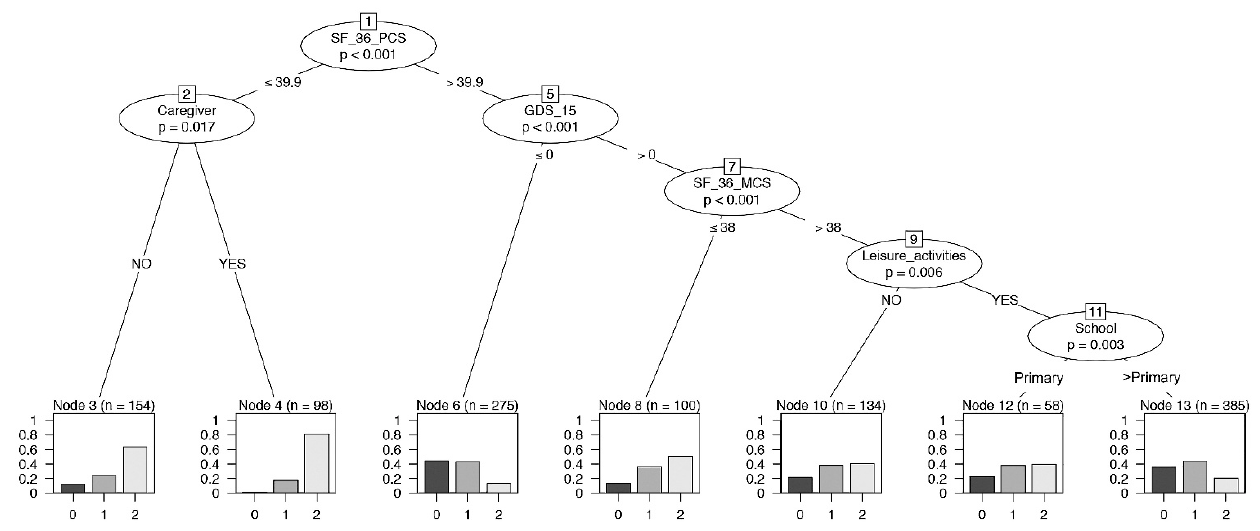
Figure 4. Binary tree computed by conditional recursive partitioning on frailty classes, global model. Effect of SF-36-PCS (the physical indicator of health-related quality of life), SF-36-MCS (the mental indicator of the quality of life), GDS-15 (0–5 = no depression, 6–9 = mild depression, 10–13 = depression), MMSE, together with sex, age groups, BMI classes, number of daily drugs (“Drugs”), absence or presence of caregiver (NO/YES), annual income, absence or presence of leisure activities (NO/YES), and level of education (School), on frailty classes (0 = robust, 1 = pre-frail, 2 = frail subjects). The variables affecting frailty are SF-36-PCS, having or not having a caregiver, GDS-15, SF-36-MCS, leisure activities, and education.